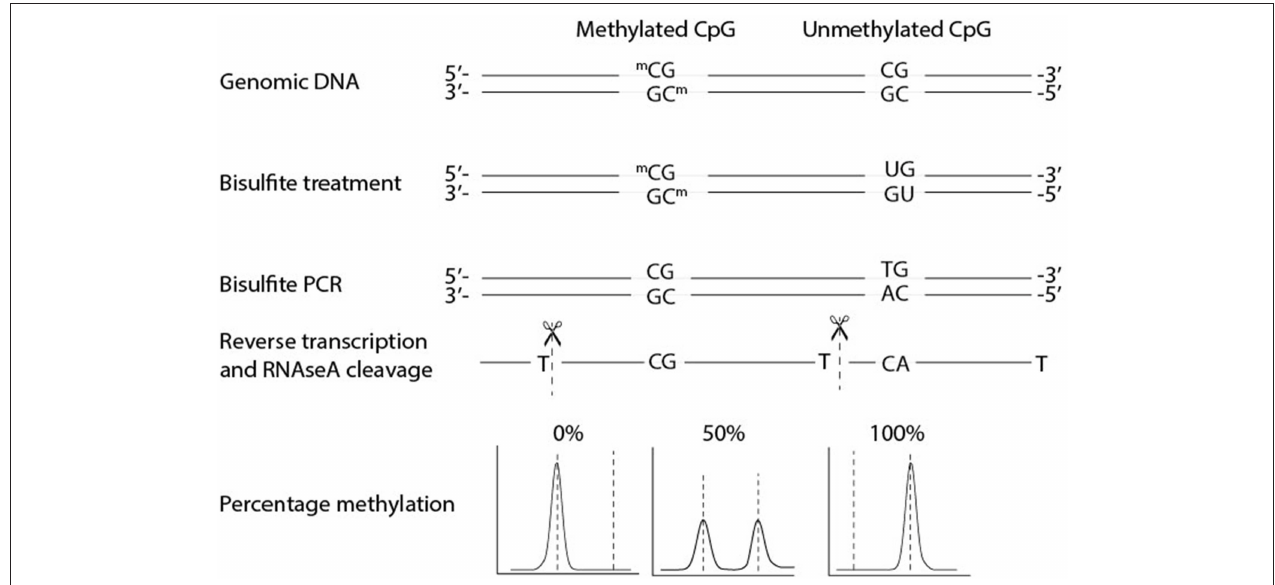
FIGURE 1 | Biochemical steps and methylation quantification with EpiTYPER ® . EpiTYPER ® resolves on re-sequencing DNA on mass. After bisulfite conversion DNA is amplified by PCR and the resulting PCR product is transcribed from the reverse strand of the PCR product. This single stranded product is cleaved after each T resulting in fragments of known mass. Fragments with a methylated cytosine are 16 Dalton heavier than fragments with a non-methylated cytosine, the size of the two peaks can be used to calculate the methylation ratio of the CpG dinucleotide. It is easy to envision that fragments can arise with the same mass or with a mass extremely close to that of another fragment. Such circumstances limit the detection of certain CpG